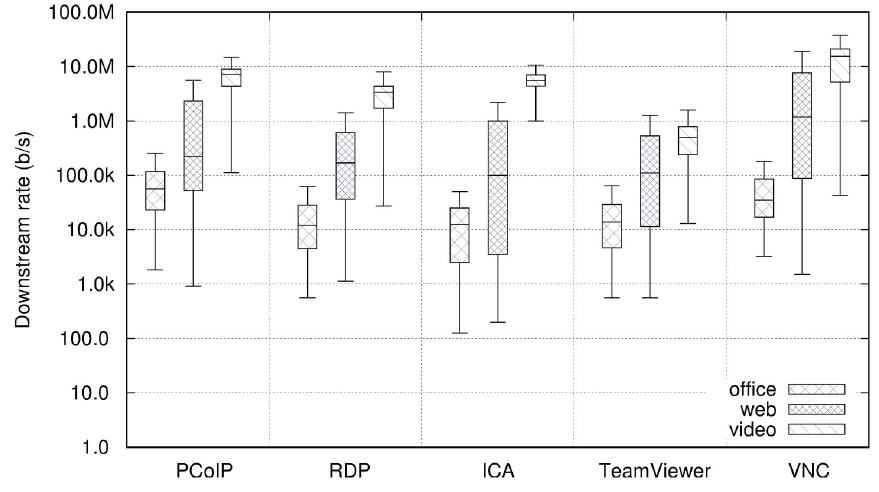
Fig 10. Comparison of downstream rate per user profile and remote desktop